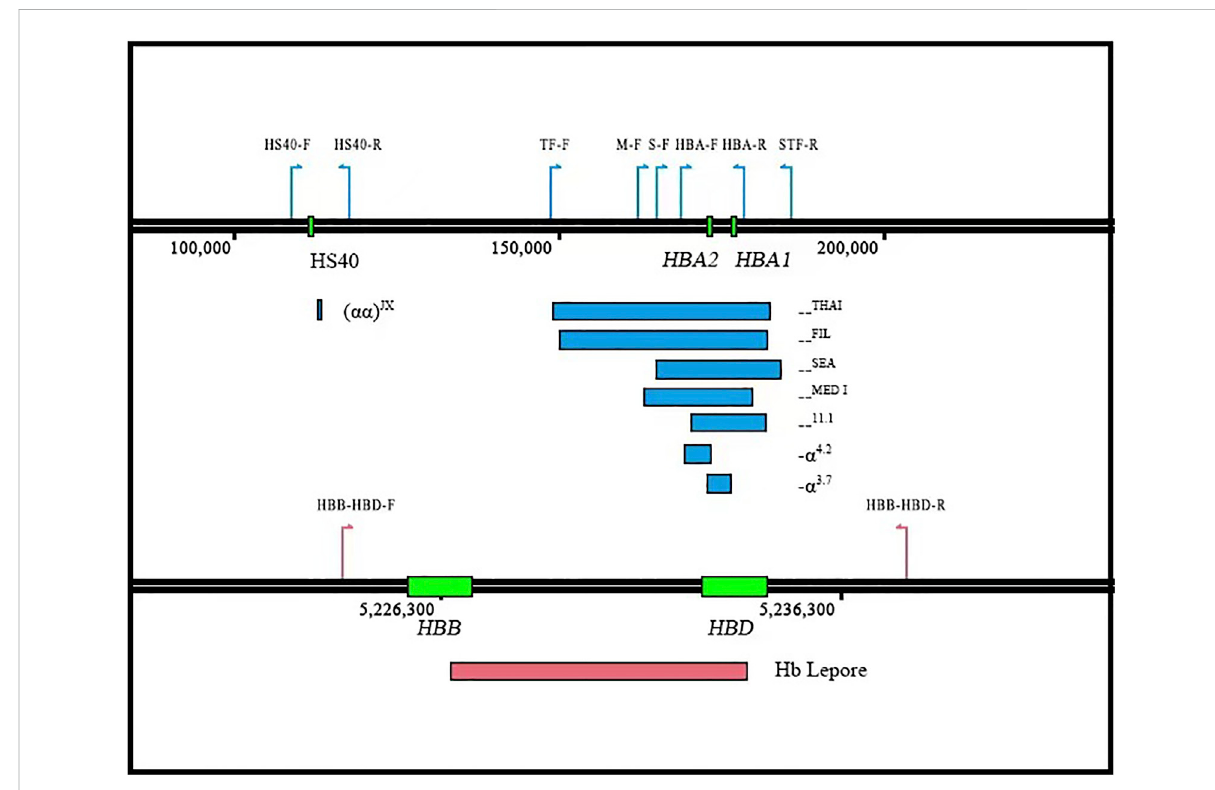
FIGURE 1 Design of the new CATSA method. Three sets of primer pairs were designed to individually detect the -- THAI and -- FIL (TF-F/STF-R), the -- SEA (S-F/STF-R), the -- 11.1 (HBA-F/STR-R), and the -- MED -I (M-F/STR-R) deletions. A fourth primer pair was designedto detect smaller deletions involving HBA1 and HBA2 (- α 3.7 ), HBA2 deletions (- α 4.2 ), and HBA1 and HBA2 SNVs/indels as well as wild-type sequences (HBA-F/HBA-R). A fi fth primer pair (HS40-F/R) wasdesigned to amplifythe( αα ) JX / αα . Asixthprimerpair (HBB-HBD-F/R)wasdesigned to amplify theentire HBBand HBDgenesto detect known SVs, SNVs, and indels. The position of the different primers is indicated by colored